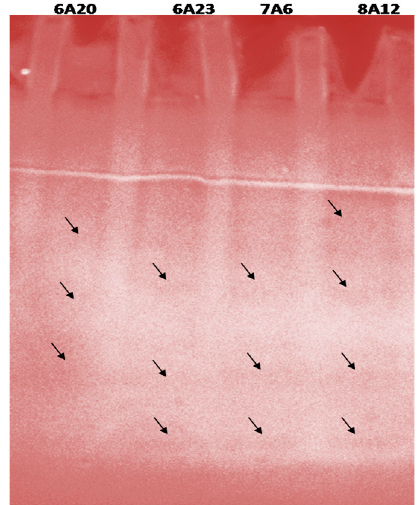
Fig. 2. Degradation of prokaryotic DNA demonstrated by in vitro DNase activity on agarose gel by the selected bacterial isolates. NG- negative control, C- control DNA